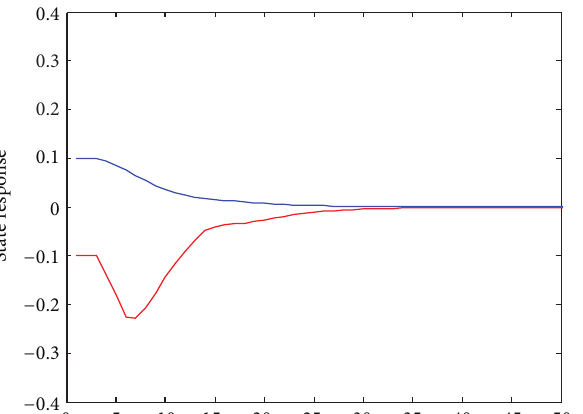
Figure 3: Values of the S-C delay 𝑑(𝑘) .